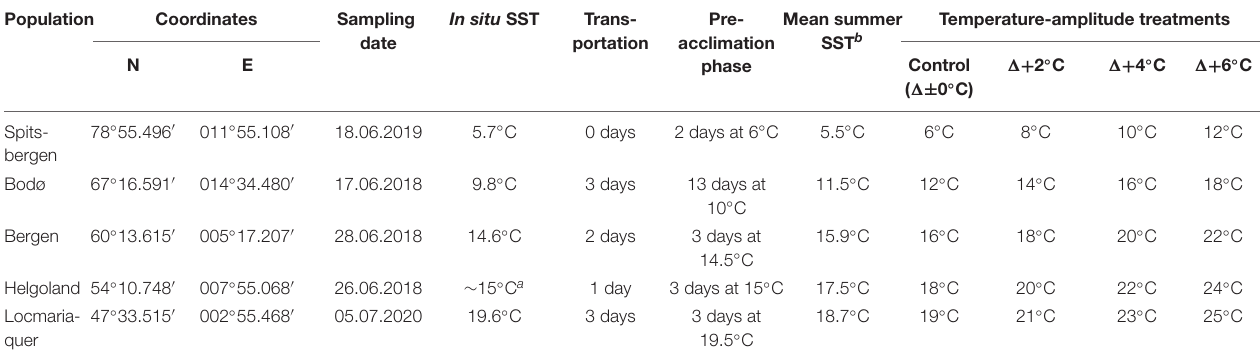
TABLE 1 | Summary of sampling of Saccharina latissima : population, North-East coordinates, in situ sea surface temperature (SST) measured while collecting on sampling day, duration of sample transportation, duration and temperature of pre-acclimation phase, satellite-obtained mean summer SST (2016–2020) and respective absolute temperatures of the temperature-amplitude treatments.